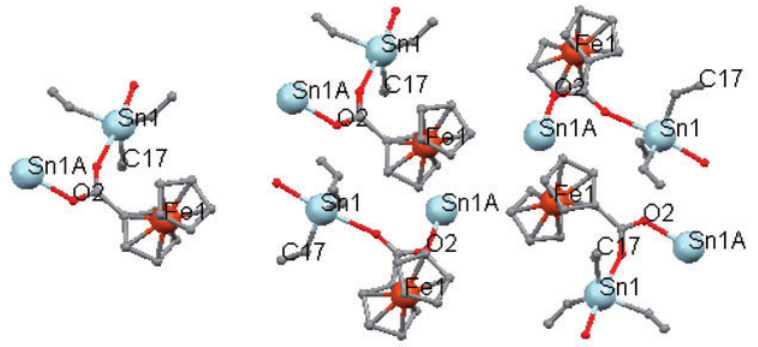
Figure 3 Scheme of the polymeric (cp)Fe(C